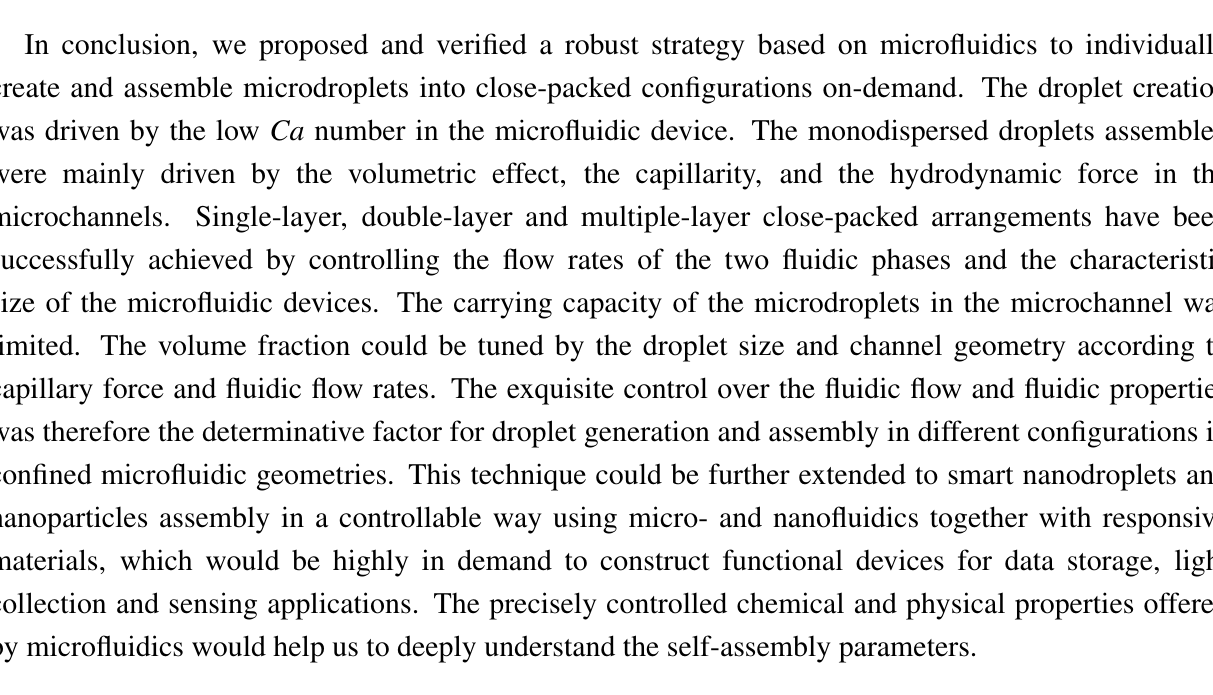
and Q were 150 and o w = 25 µ m, d = 40 µ m f c